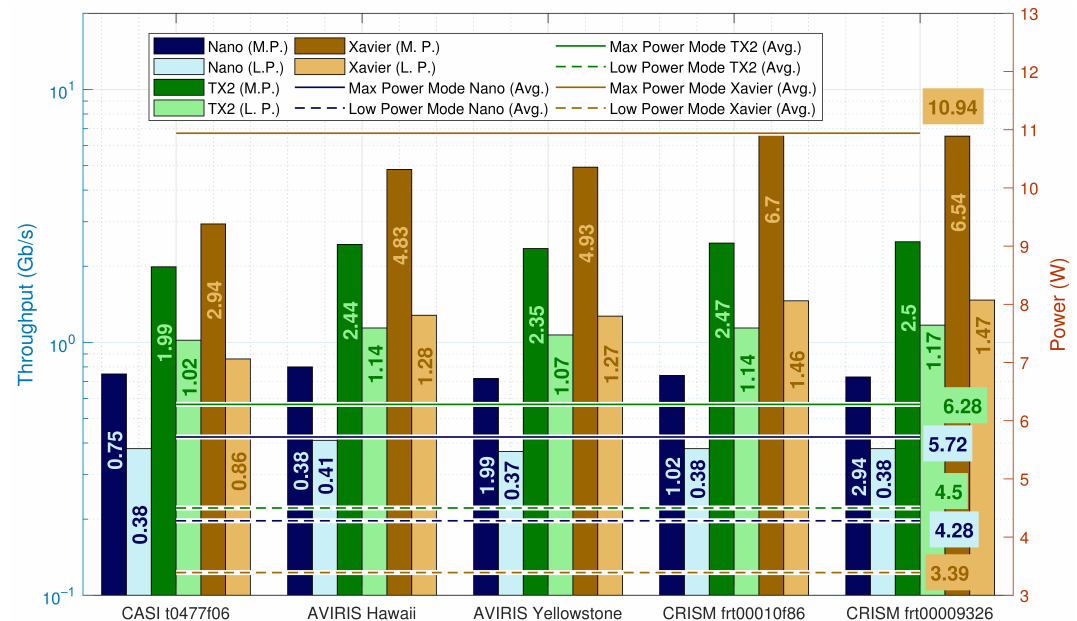
Figure 6. Throughput performance for maximum power and low power modes across all platforms. The left axis represents throughput (bars) and the right one represents the average power (continuous and dashed lines) for the maximum and low power